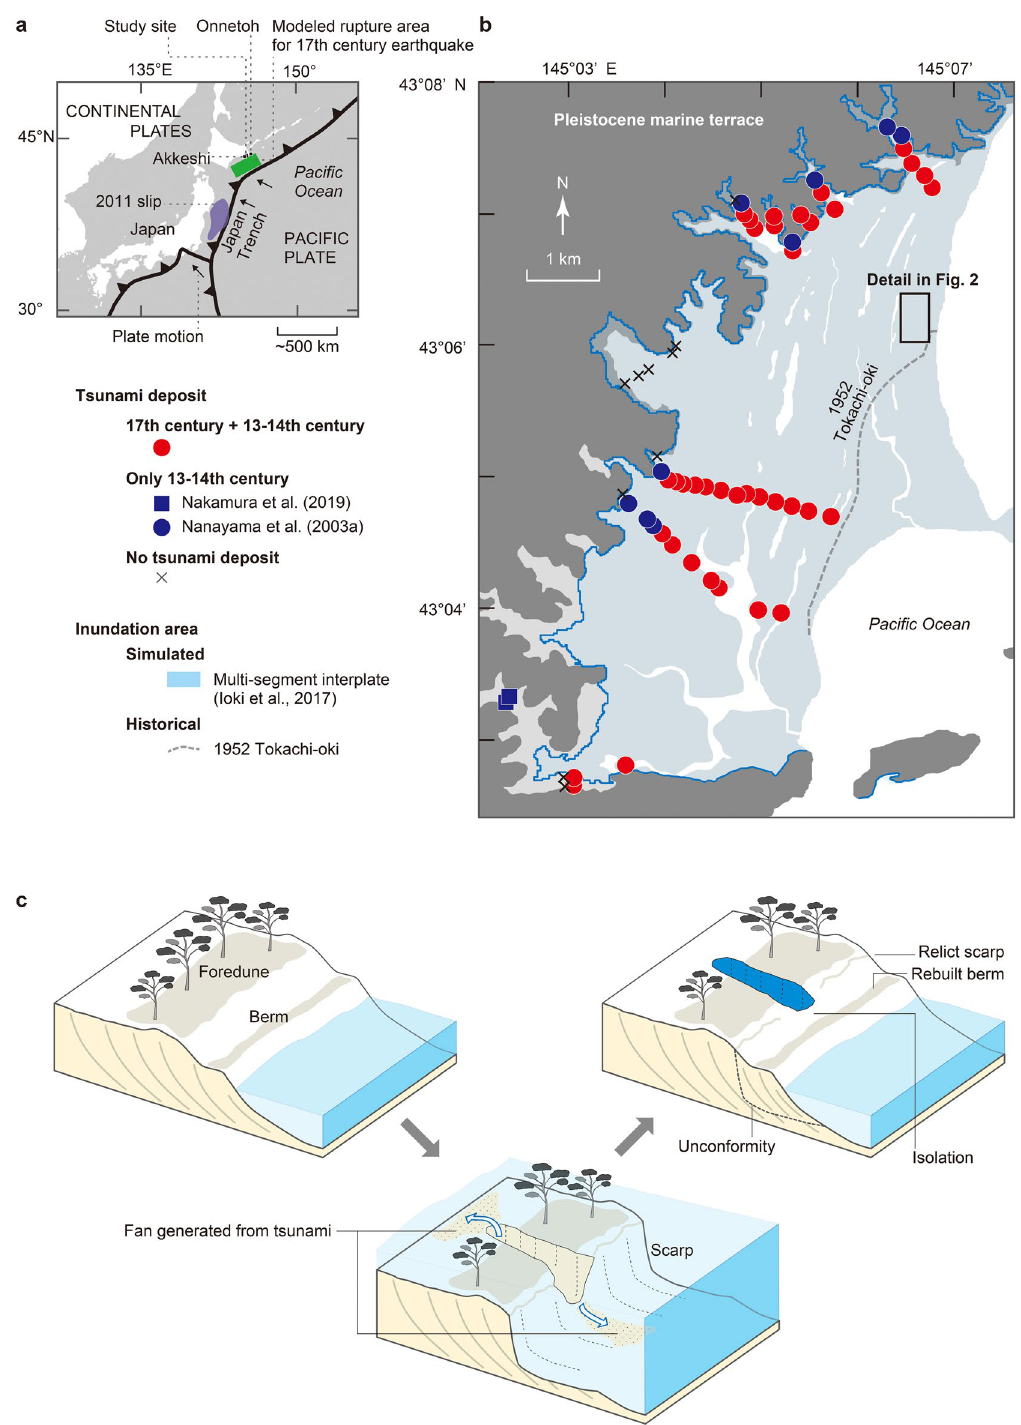
Figure 1. ( a ) Tectonic setting of Japan and location of the study site. The rupture of the 2011 earthquake is from Ozawa et al. (2011) 63 . ( b ) Map of the Kiritappu marsh showing distributions of tsunami deposits formed in the seventeenth century and thirteenth-fourteenth century 3,64 , historical tsunami inundation area 3,5 , simulated inundation area from a multi-segment interplate earthquake tsunami 3,5,7 , and Pleistocene marine terraces 65 . Inter-ridge ponds defined by beach ridges trend parallel to the present shoreline. ( c ) Cartoon showing the formation of a scour pond. The foredune and berm are reamed out perpendicular to the contemporary shoreline by inflow and outflow currents. The resulting scour pond then becomes isolated as the sandy beach is rebuilt with drift sand due to daily tides. The fan deposit created by inflow currents remains as a tsunami deposit upon the foredune and marsh. Generic Mapping Tools 66 was partly used to create Fig. 1a. Figure 1b was modified from Sawai 1